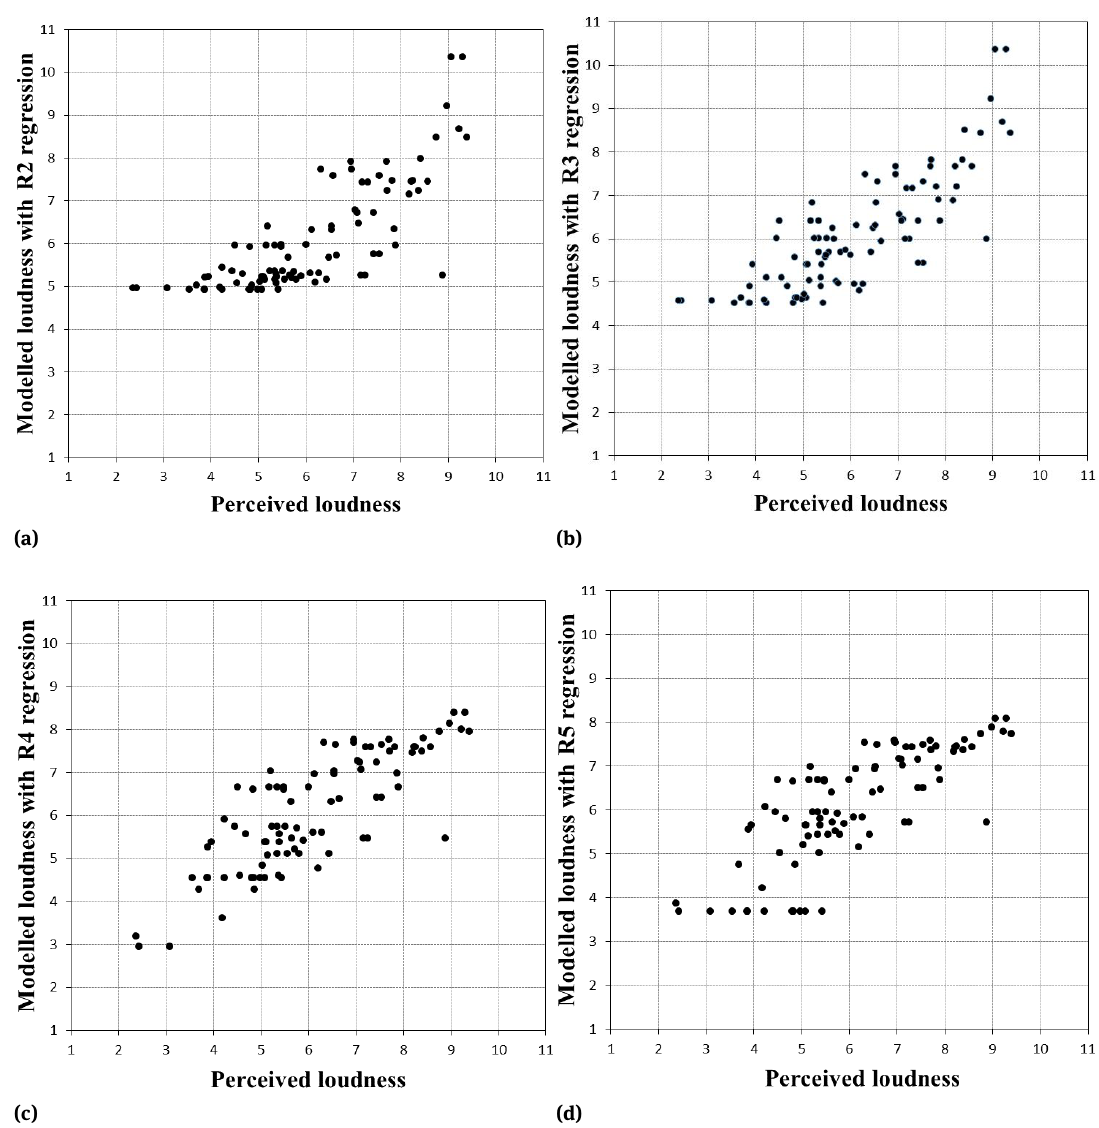
Figure 5: Relations between perceived and modelled loudness with the different